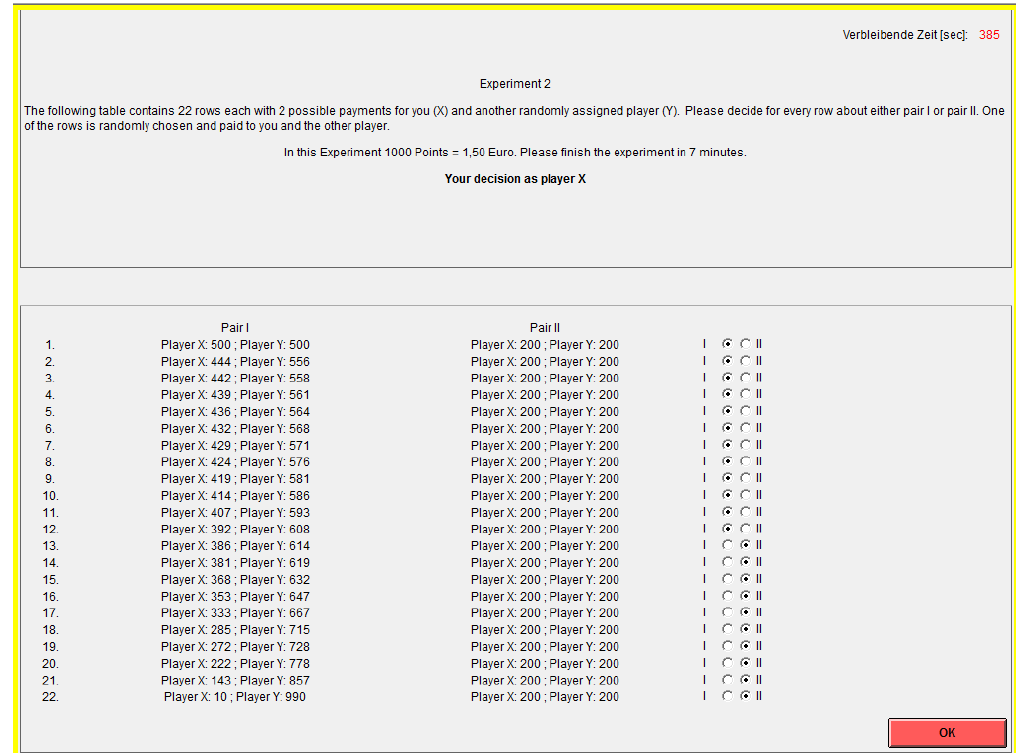
Figure A1. Z-Tree Screenshot of Elicitation of Unfavored Inequality Aversion. Notes: Players have to decide upon one of each column in every row. The procedure is as proposed by Danneberg et al. 2007.